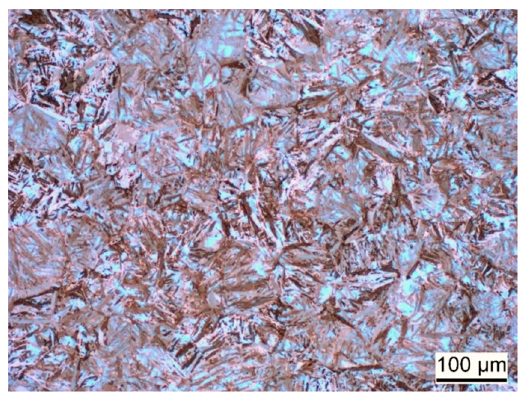
Figure 3. Light-microscopic image of etched sample, showing martensitic microstructure of the hardened and tempered steel.